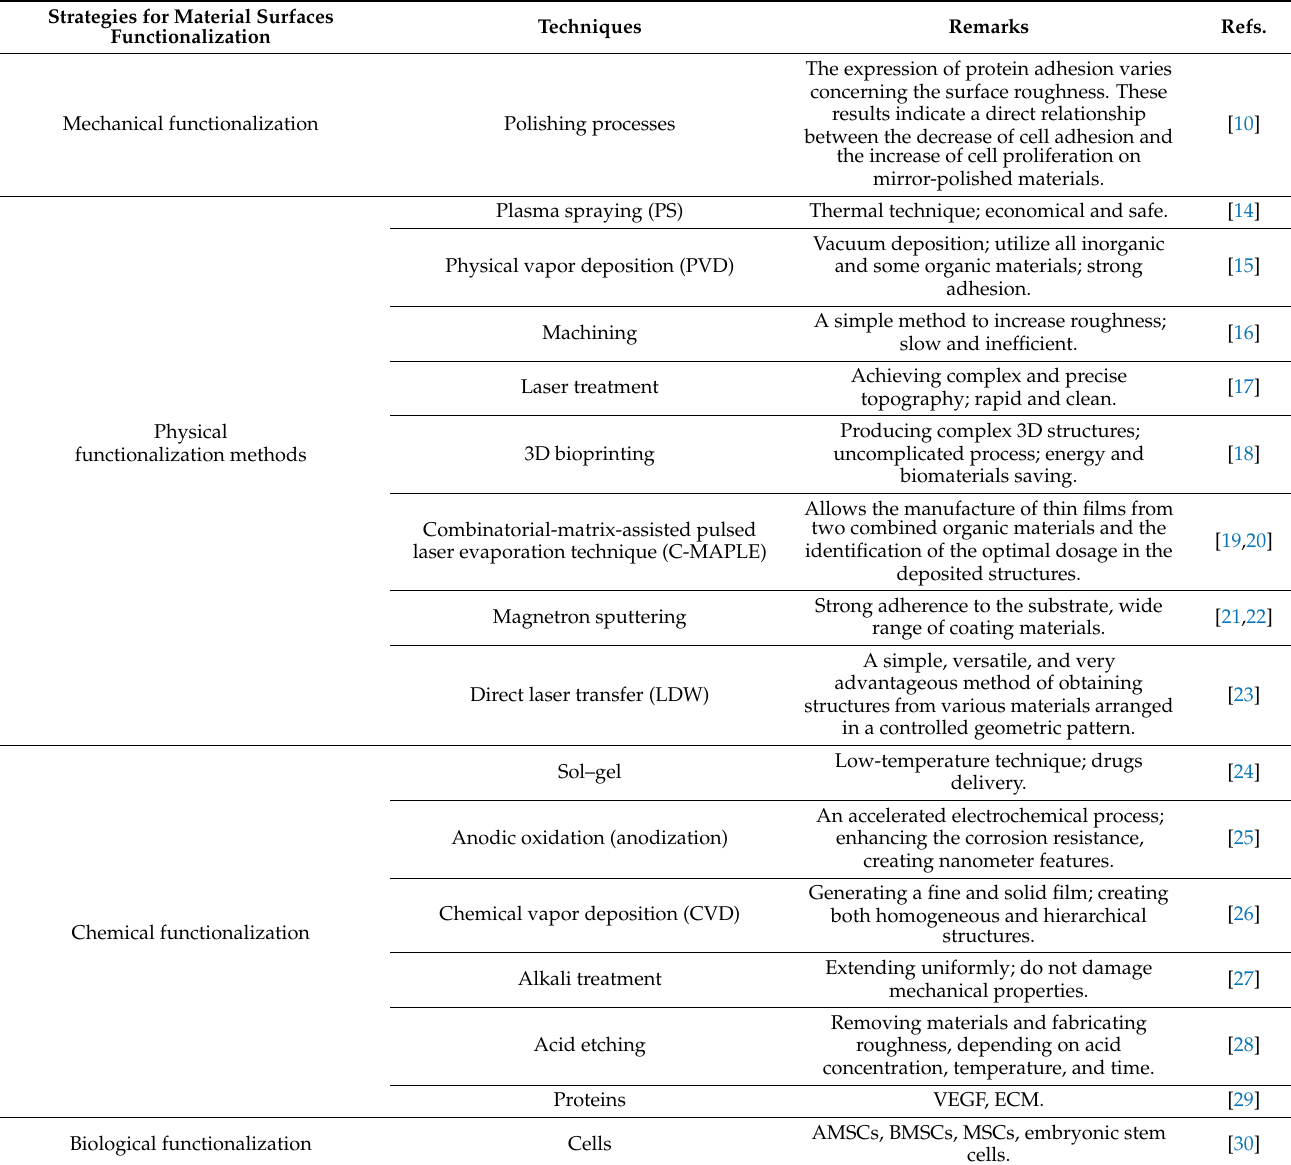
Table 1. Summary of surface functionalization